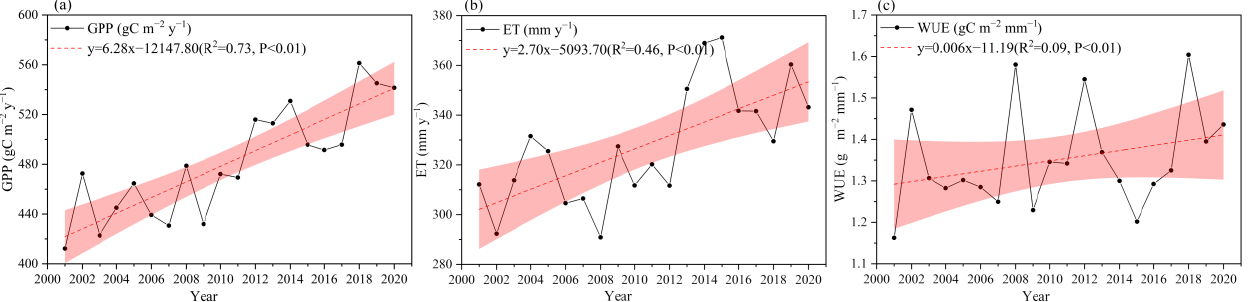
Figure 2. Interannual variations of ( a ) GPP, ( b ) ET, and ( c ) WUE in Inner Mongolia from 2001 to 2020 (The red shades highlight the 95% confidence interval. The black lines are time series of regional annual GPP, ET, and WUE, while the red dashed lines represent the trend).